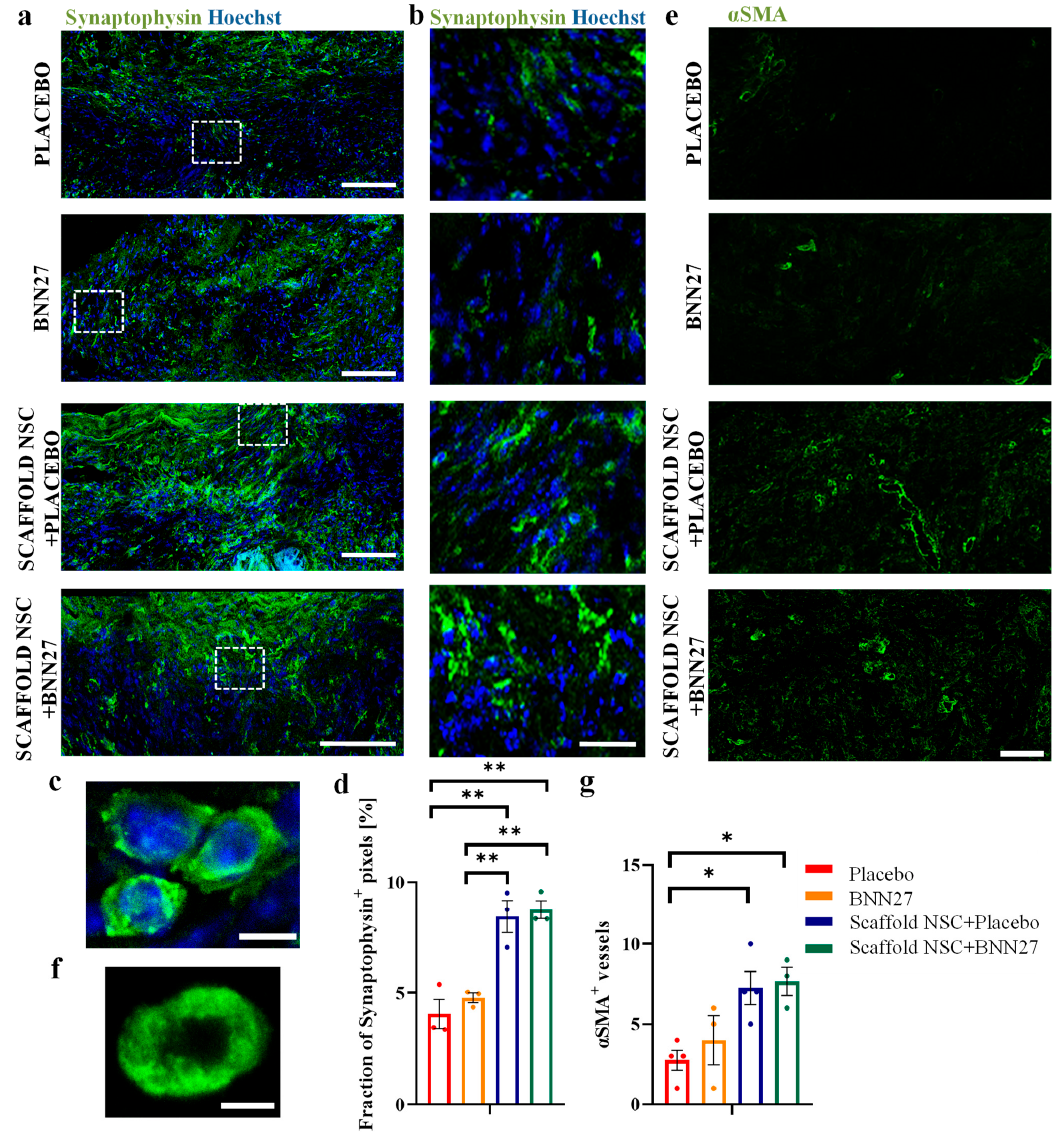
Figure 3. Effects of NSC-seeded PCS grafts on synapse density and angiogenesis. ( a ) Representative fluorescence images of spinal cord parasagittal sections in the lesion epicenter from all four injured groups immunostained for synaptophysin (green). Scale bars: 100 µ m. ( b ) High-magnification fluorescence images of the rectangular ROIs of image ( a ) showing synaptophysin immunostaining in the lesion epicenter. Scale bars: 50 µ m. ( c ) A representative high-magnification fluorescence image immunostained for synaptophysin. Scale bar: 5 µ m. ( d ) Quantification of synaptophysin + pixel fraction within the lesion epicenter in the four injured groups at 12 wpi (All groups: n = 3). ( e ) Representative fluorescence images of spinal cord parasagittal sections in the lesion epicenter from all four injured groups immunostained for α SMA (green). Scale bar: 50 µ m. ( f ) A representative high-magnification fluorescence image of a vessel in the lesion epicenter immunostained for α SMA. Scale bar: 5 µ m ( g ) Quantification of the number of α SMA + vessels within the lesion epicenter in the four injured animal groups at 12 wpi (“Placebo”: n = 4, “BNN27”: n = 3, “Scaffold NSC + Placebo”: n = 4, “Scaffold NSC + BNN27”: n = 3). Results are presented as mean ± SEM. * p < 0.05, ** p < 0.01; Tukey’s post hoc pairwise test assuming P 2-way-ANOVA <